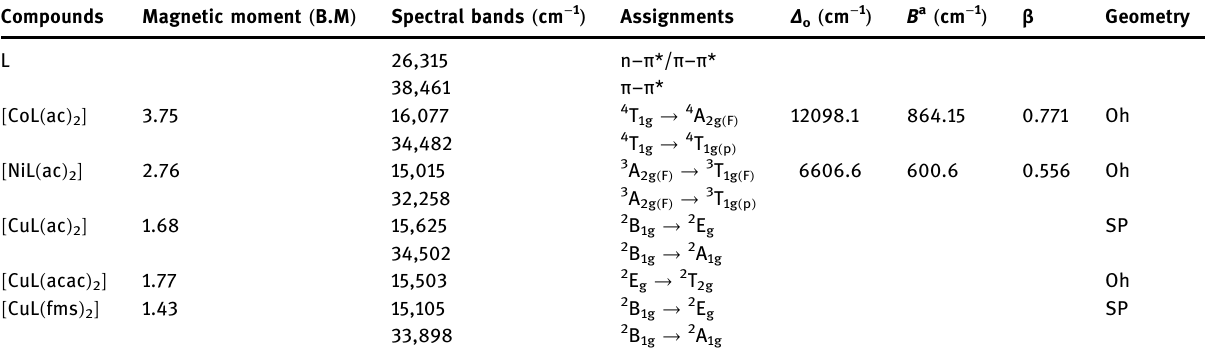
Table 3: Electronic spectral and magnetic moment data of metal complexes Compounds Magnetic moment ( B.M )